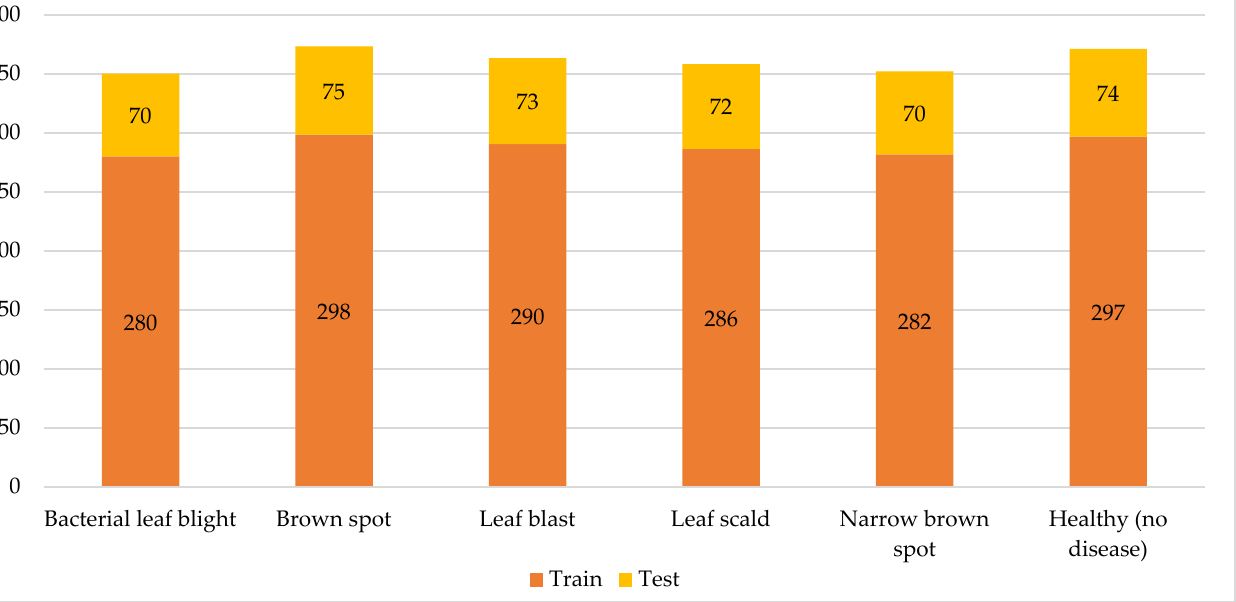
Figure 2. Distribution of train and test rice leaf images for different rice diseases.